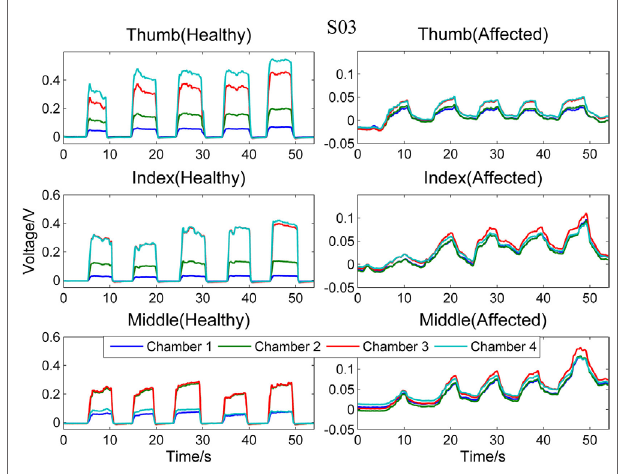
FigUre 3 | comparison between healthy and affected hands of s03 . Signals recorded from the four chambers of the finger sensor when three different types of finger actions were performed by S03, namely compressing the sensor body with thumb, index finger, and middle finger,